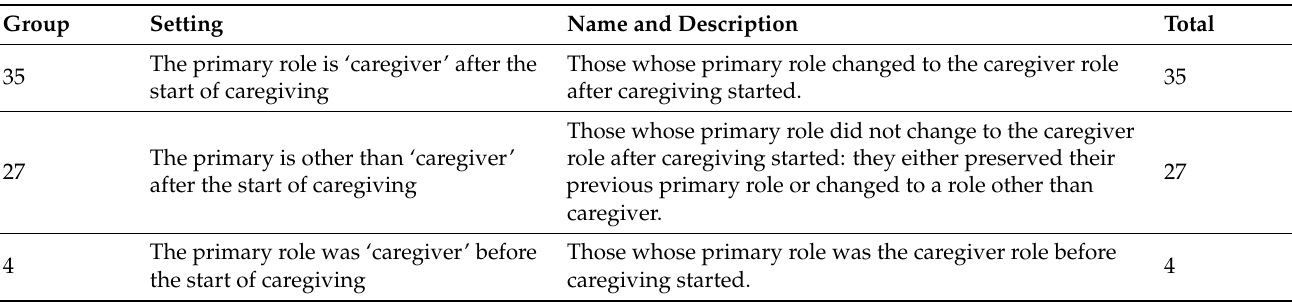
Table 3. Groups of respondents.